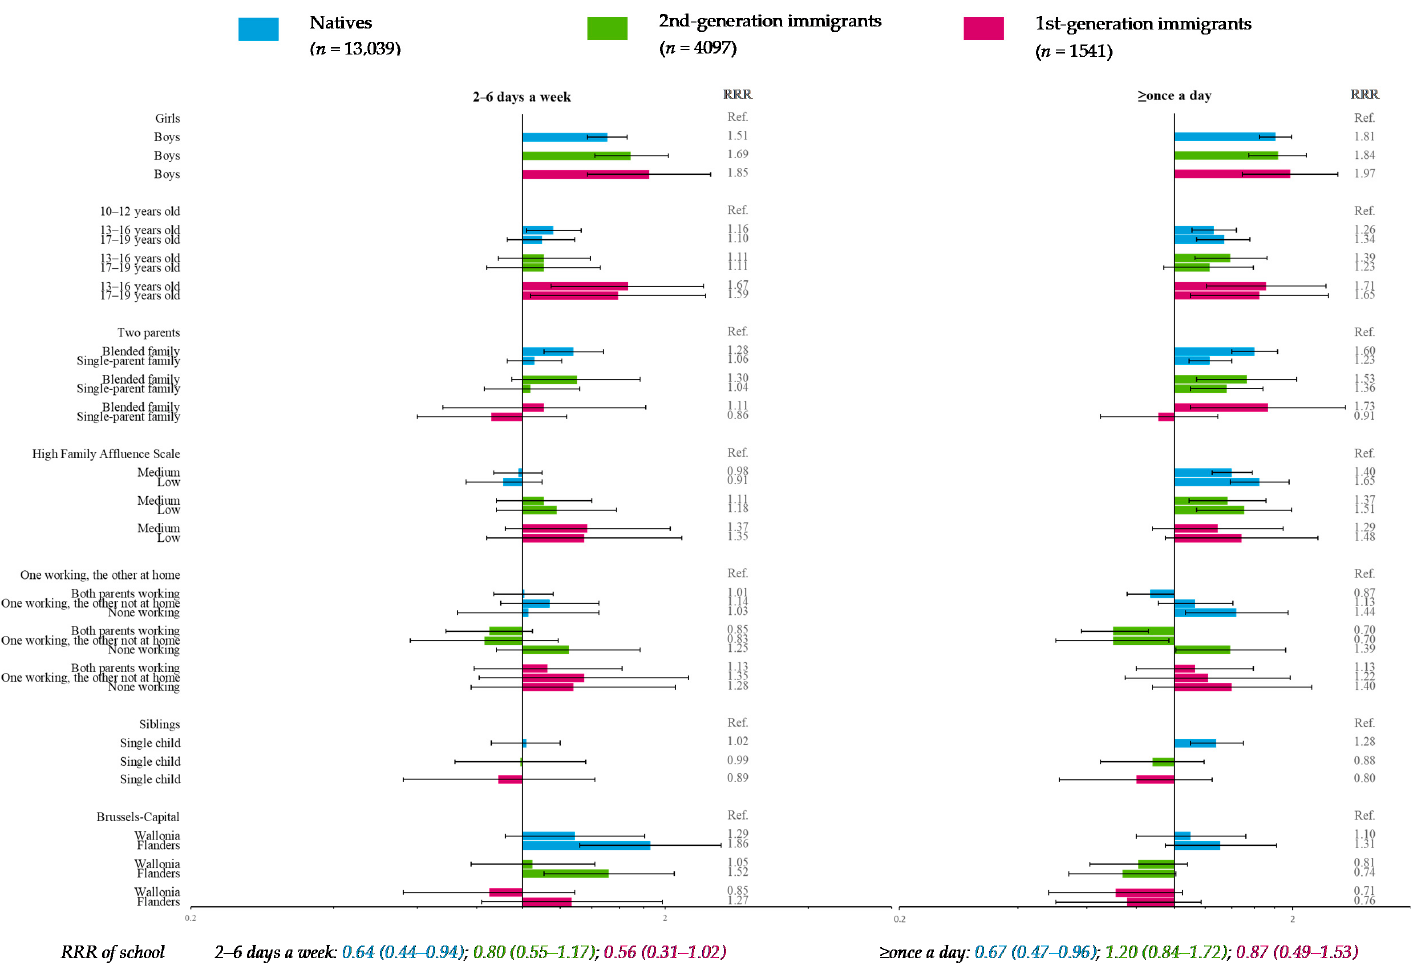
Figure 8. Multiple multilevel multinomial regression* for sugar-sweetened beverages consumption (reference category: ≤ once a week) stratified by migration status—HBSC, Belgium, 2014 ( n = 18,642). * RRR < 1: More favorable for health; RRR > 1: Less favorable for health.